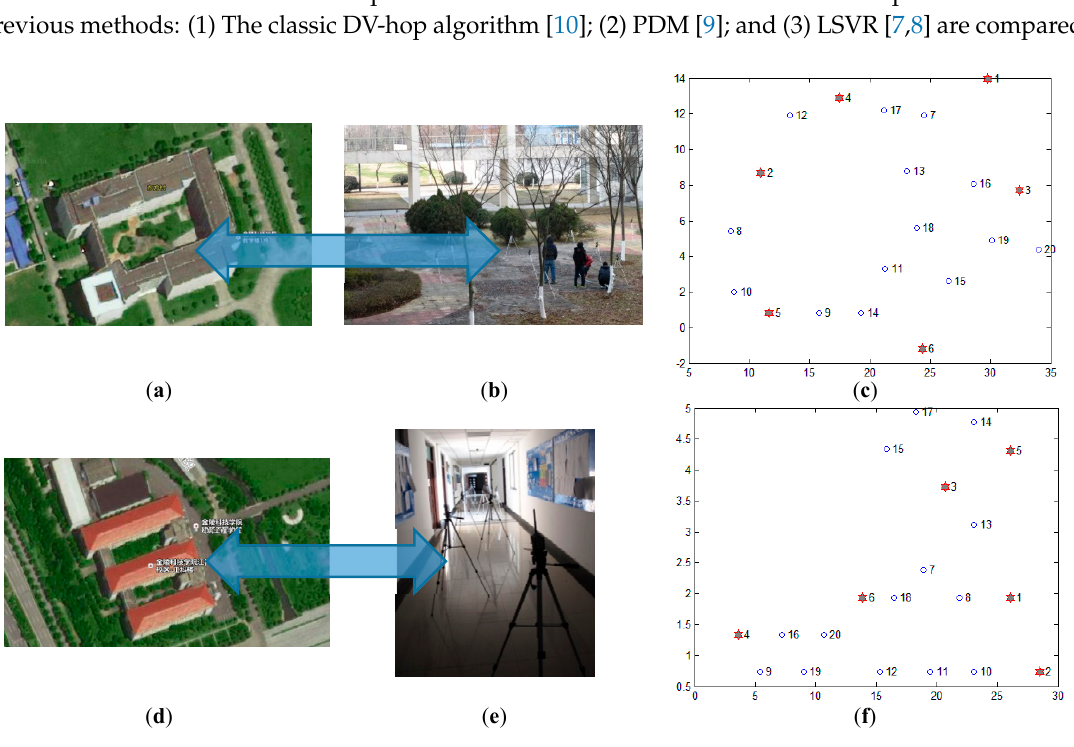
Figure 13. Nodes distribution under realistic scenarios ( a ) Satellite picture of outdoor location; ( b ) Picture of outdoor test-bed; ( c ) Topological graph of outdoor test-bed; ( d ) Satellite picture of indoor location; ( e ) Picture of indoor test-bed; ( f ) Topological graph of indoor test-bed.